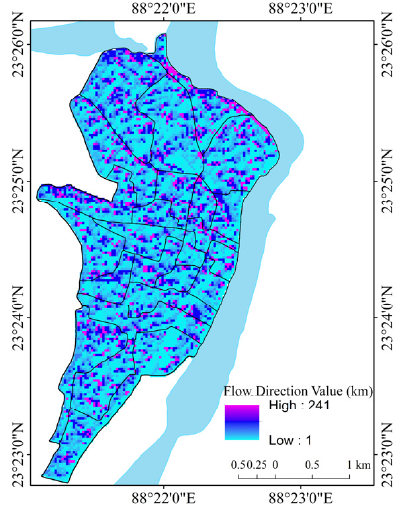
Figure 31. Flow direction (2015).